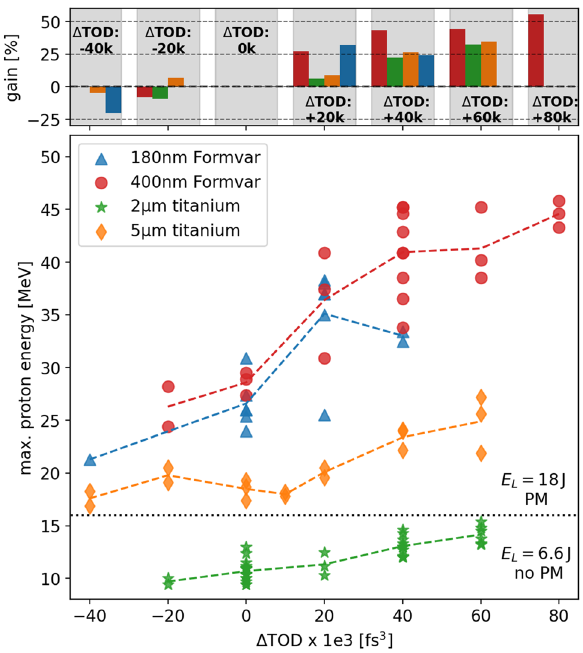
Figure 4. Maximum proton energy with respect to (cid:31) TOD ( (cid:31) GVD = 0) for different target materials and thicknesses (represented by different markers and colors) as well as on target laser energy ( E L ) and temporal contrast (PM and no PM) settings. The upper plot shows the relative energy gain with respect to the standard settings for the different target types and (cid:31) TOD